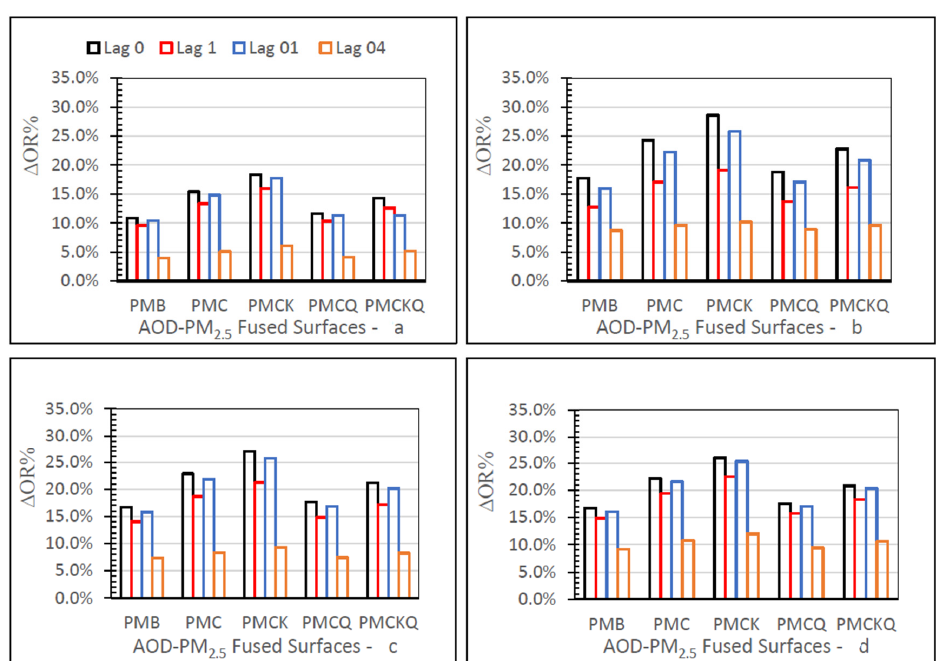
Figure 8. Warm-cold season ∆ OR% values for the four AOD-PM 2.5 and baseline PMB fused surfaces at lag grids 0, 1, 01, and 04 for ED asthma ( a ), IP asthma ( b ), IP MI ( c ), and IP HF ( d ), in different panels.